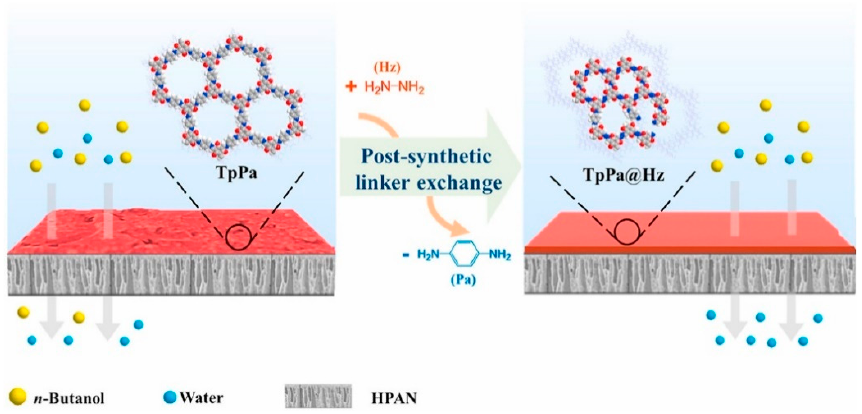
Figure 23. Schematic of post synthetic linker exchange method for the fabrication of COF mem- branes.